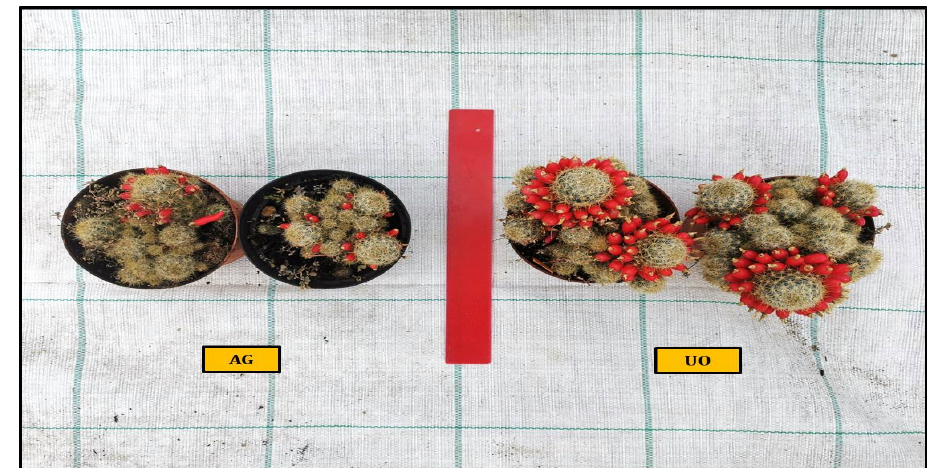
Figure 2. Comparison of vegetative growth and fruit production of Ulva ohnoi (UO) and Ecklonia maxima (AG) in Mammillaria prolifera.